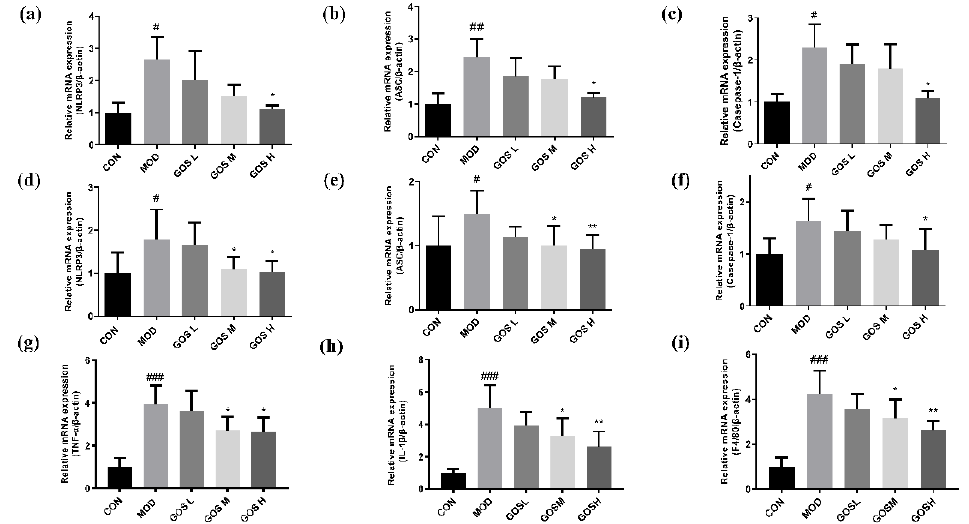
Figure 10. Effects of GOS on the NLRP3 inflammasome and inflammatory genes ( n = 6, means ± SD) . ( a – c ) NLRP3, ASC, and Caspase-1 mRNA expression in L02 liver cells. ( d – f ) NLRP3, ASC and Caspase-1 mRNA expression in mouse livers. ( g – i ) TNFα, IL - 1β and F4/80 mRNA expression in